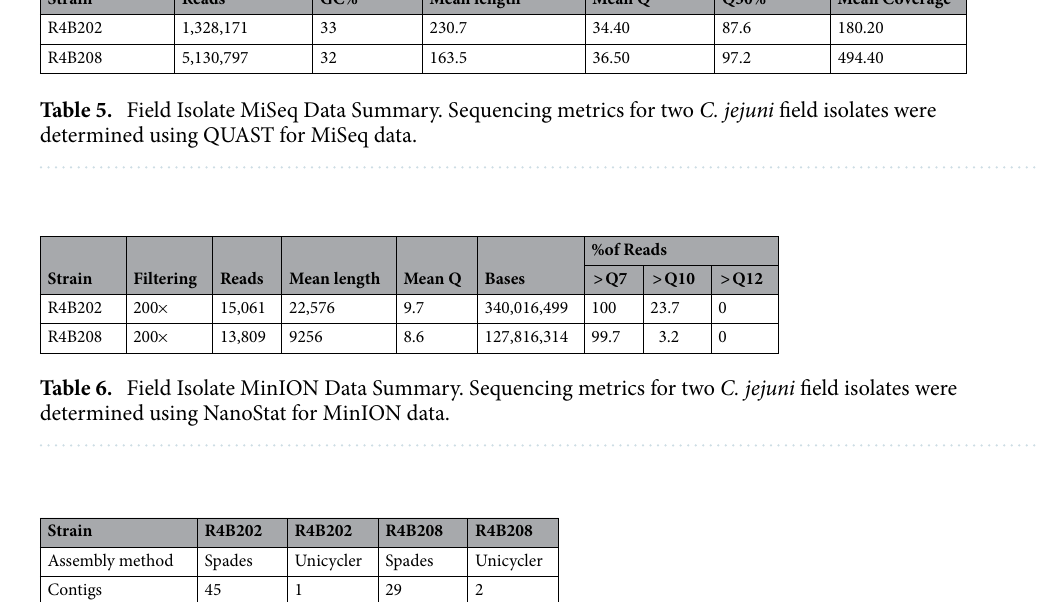
Figure 1. C. jejuni Reference Strain Assembly Graphs. The SPAdes, Canu, and Unicycler genome assembly graphs for C. jejuni reference strains RM1221 and 81-176 were visualized using Bandage. The colors denote different nodes, and the black connecting lines represent known overlaps. Branching node intersections are caused by multiple potential overlapping nodes. Strain